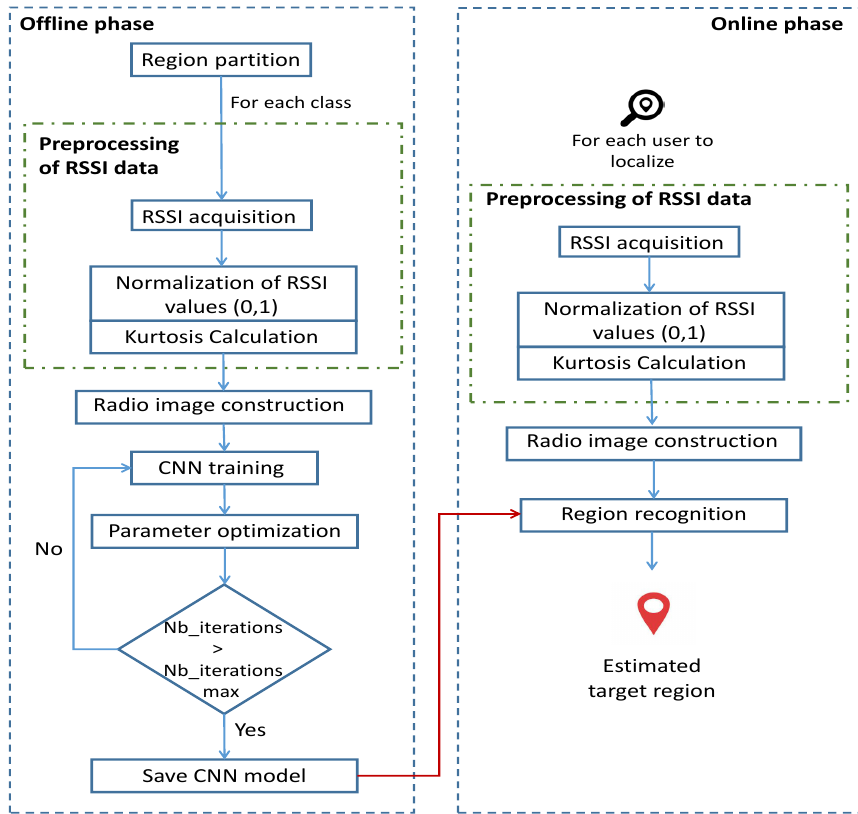
Figure 1. Different steps of our CNN-based localization system.